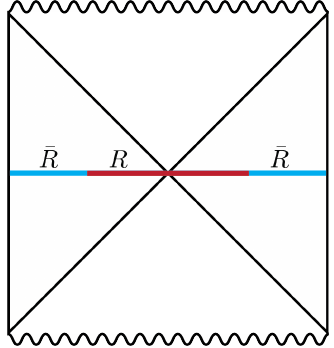
Figure 2 . The bulk gravitational system we study in this paper is dual to a BCFT thermal state on a nongravitating black-hole background. We compute the entropy of the subregion R , a connected interval that runs through the bifurcation surface (the horizon at t = 0 separating the past and future horizons, represented by the point in the middle of the Penrose diagram above), using the holographic RT prescription. This bipartition is similar to that in a recent work [109] studying entanglement islands in de Sitter